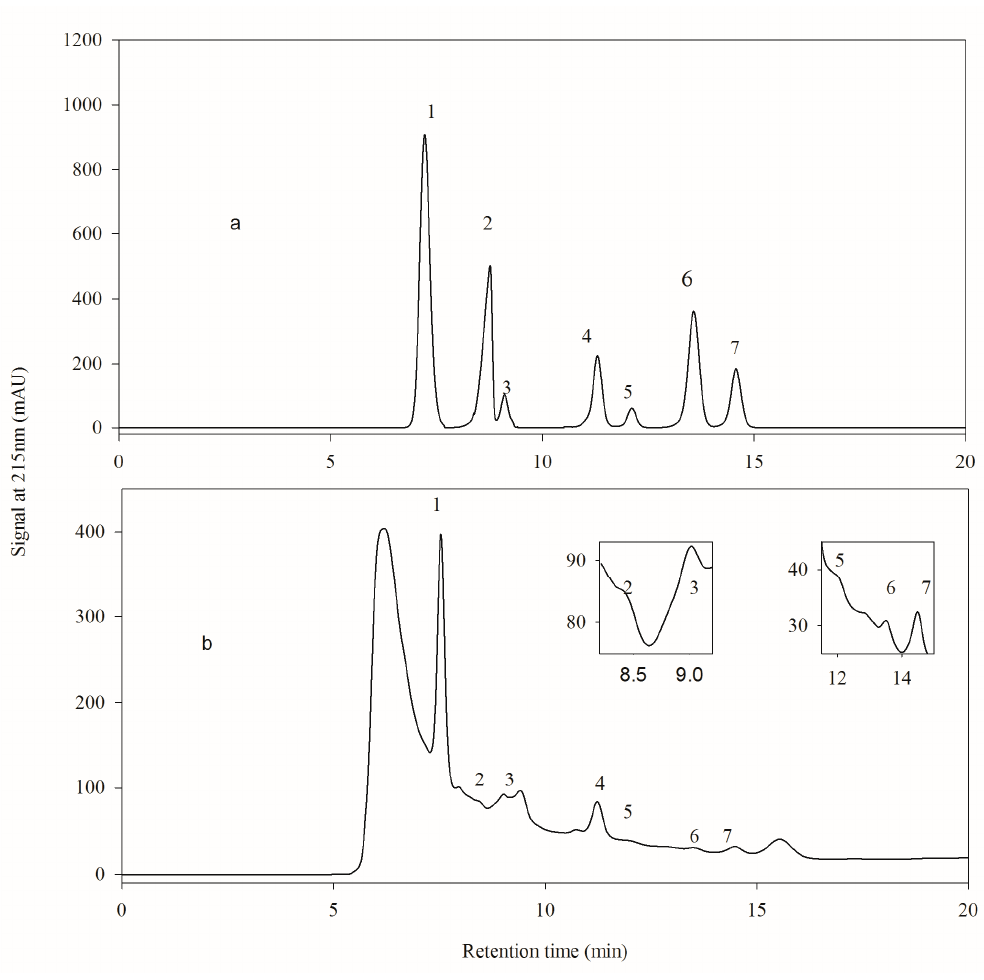
Figure 1. Analysis of organic acids with HPLC method 1. ( a ) Chromatogram of organic acid standards; ( b ) Chromatogram of hawthorn wine. Peak 1, 2, 3, 4, 5, 6 and 7 were citric acid, pyruvic acid, L ‐ malic acid, succinic acid, lactic acid, fumaric acid, and acetic acid.